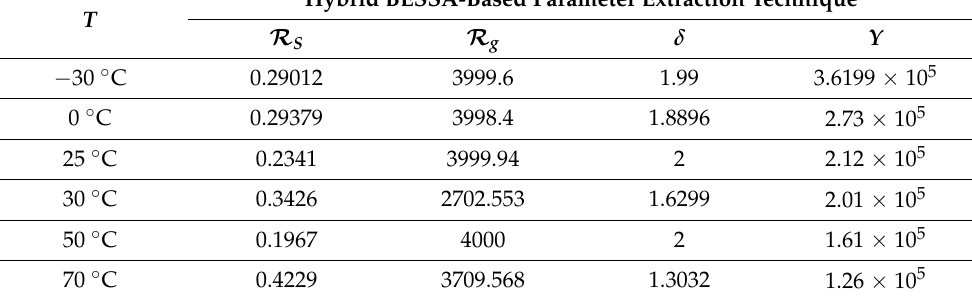
Table 8. Parameters of the Photovoltaic Module AS-M3607-S (G1 CELLS) obtained using the Hybrid BESSA- and BES-based parameter extraction technique with G fixed at 1000 W/m 2 and T varying from − 30 ◦ C to 70 ◦